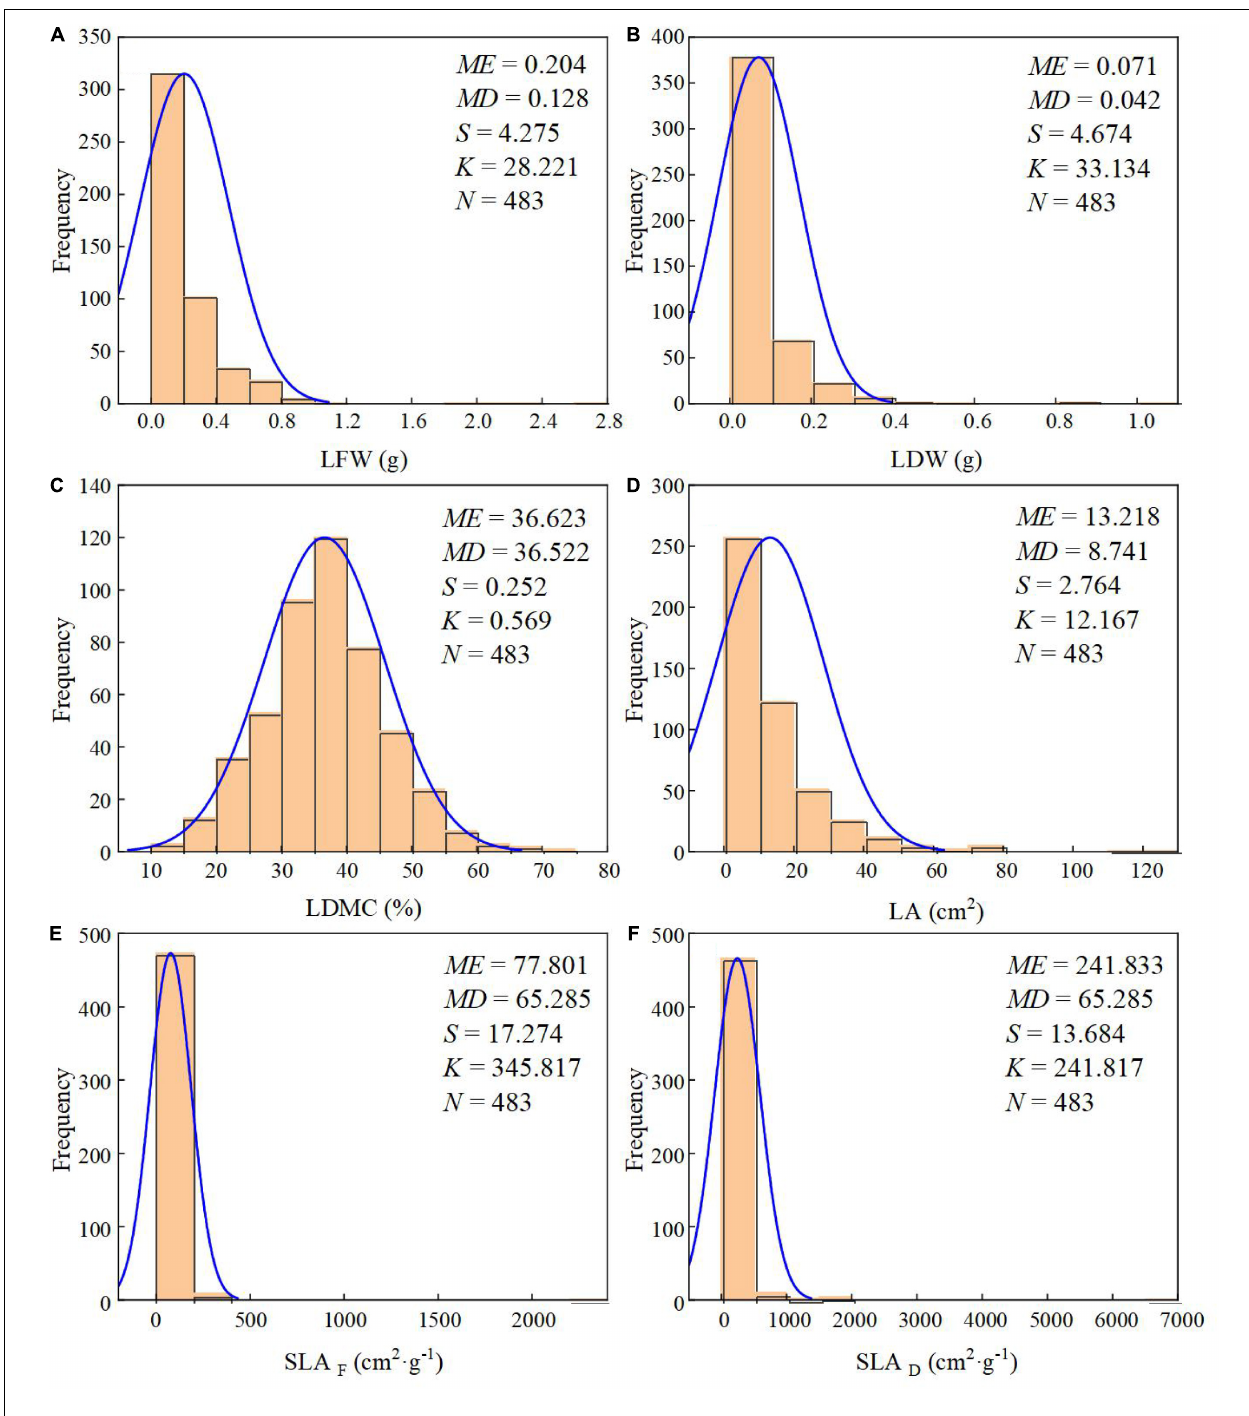
FIGURE 1 | Frequency distribution histogram and normality test of leaf traits. (A) LFW; (B) LDW; (C) LDMC; (D) LA; (E) SLA F -based fresh weight; and (F) SLA D -based dry weight. ME, mean value; MD, median value; S, skewness; K, kurtosis; N, total